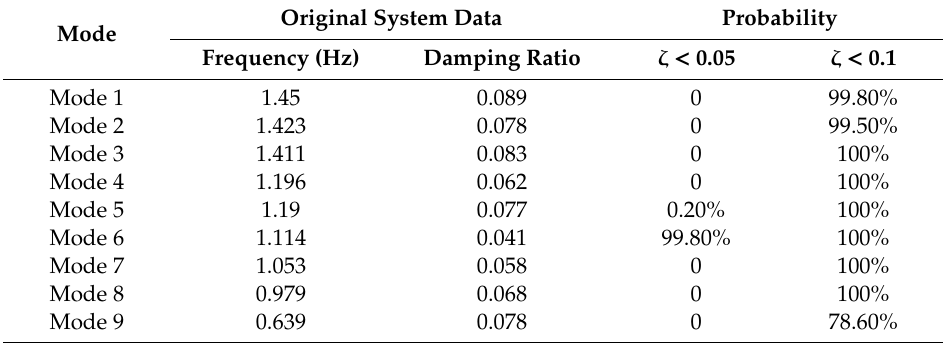
Table 1. The damping ratio and the probability of LFO modes.